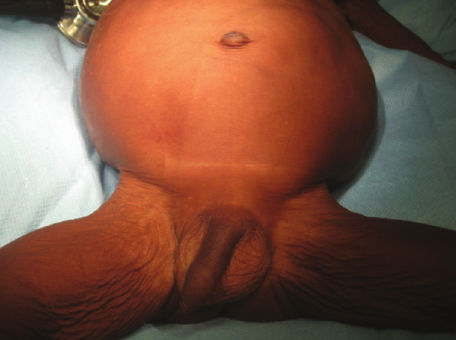
Figure 1: Distended abdomen in a lean baby who weighed 62% of expected weight.